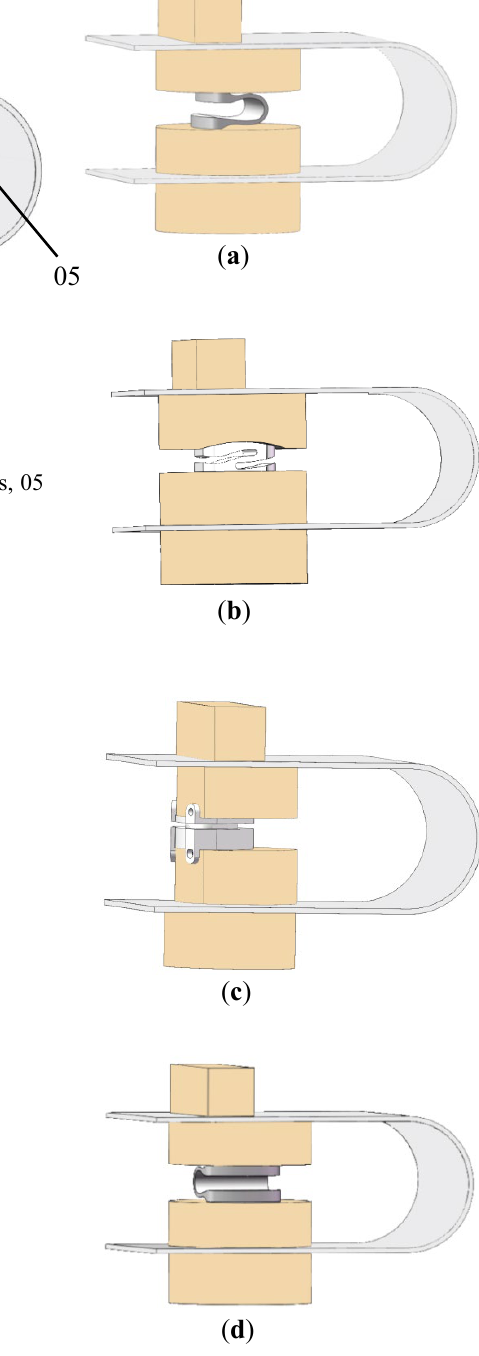
Figure 1. Assembly drawing of fixture and prostheses: ( a ) Dynamic Cervical Implants DCI under the flexion or extension condition; ( b ) Z-braze Dynamic Fusion under the flexion or extension condition; ( c ) Prestige LP under the flexion or extension condition; ( d ) DCI under the lateral bending condition.